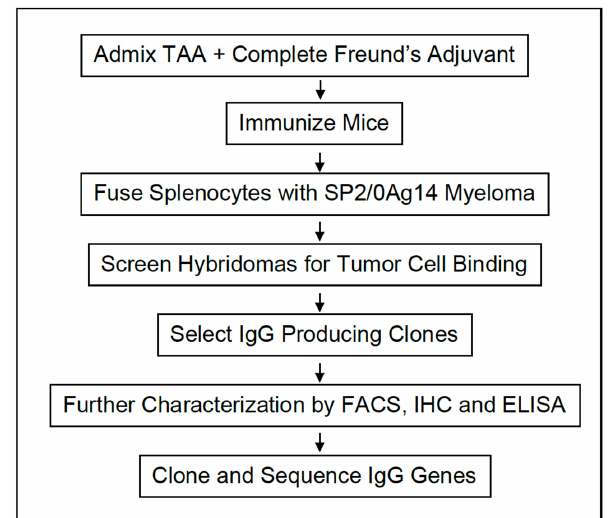
Figure 1. Flow diagram of monoclonal antibody production.